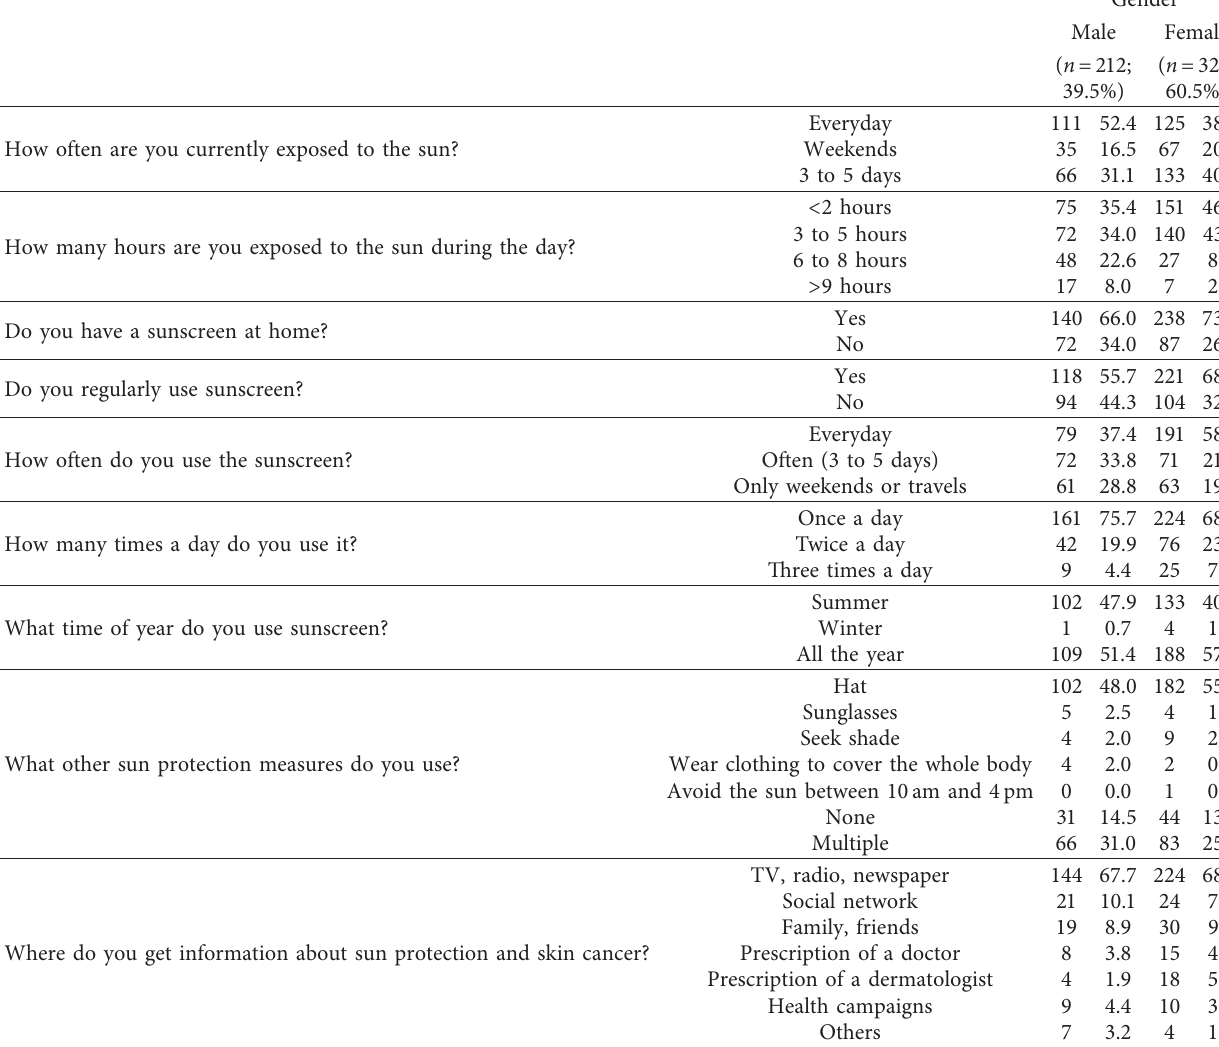
Table 5: Practice questionnaires of skin